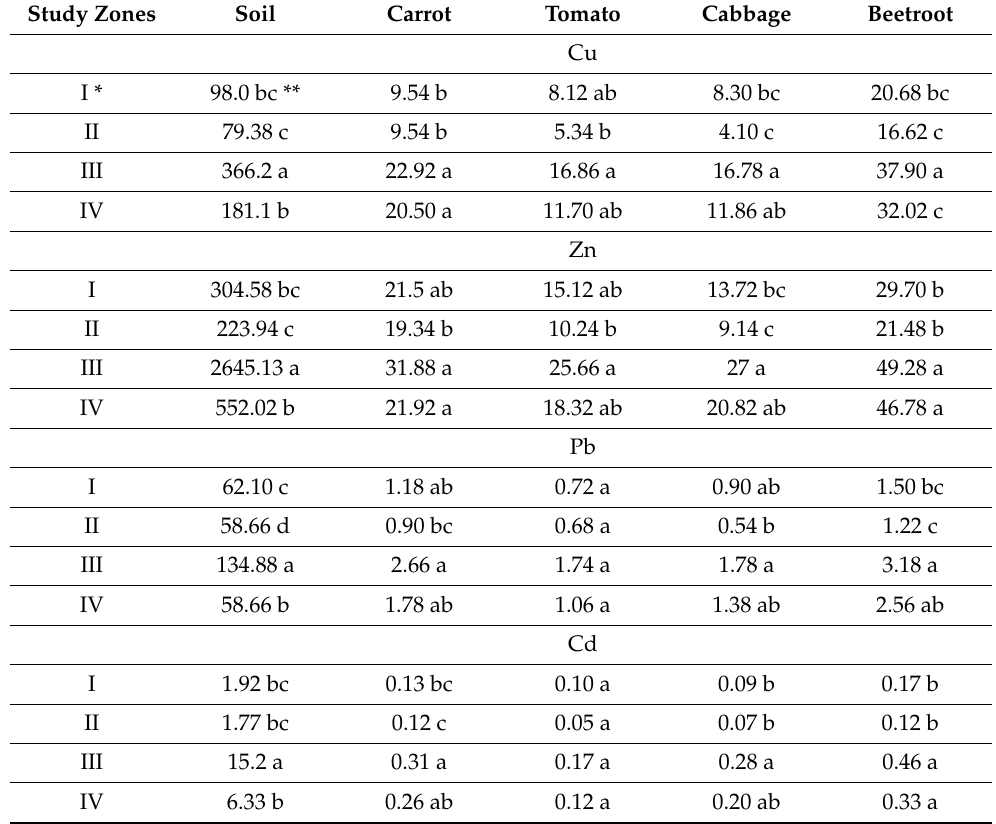
Table 2. Metal content in soils and plants in relation to individual areas of the city (mg · kg − 1 ). Study Zones Soil Carrot Tomato Cabbage Beetroot Cu 98.0 bc